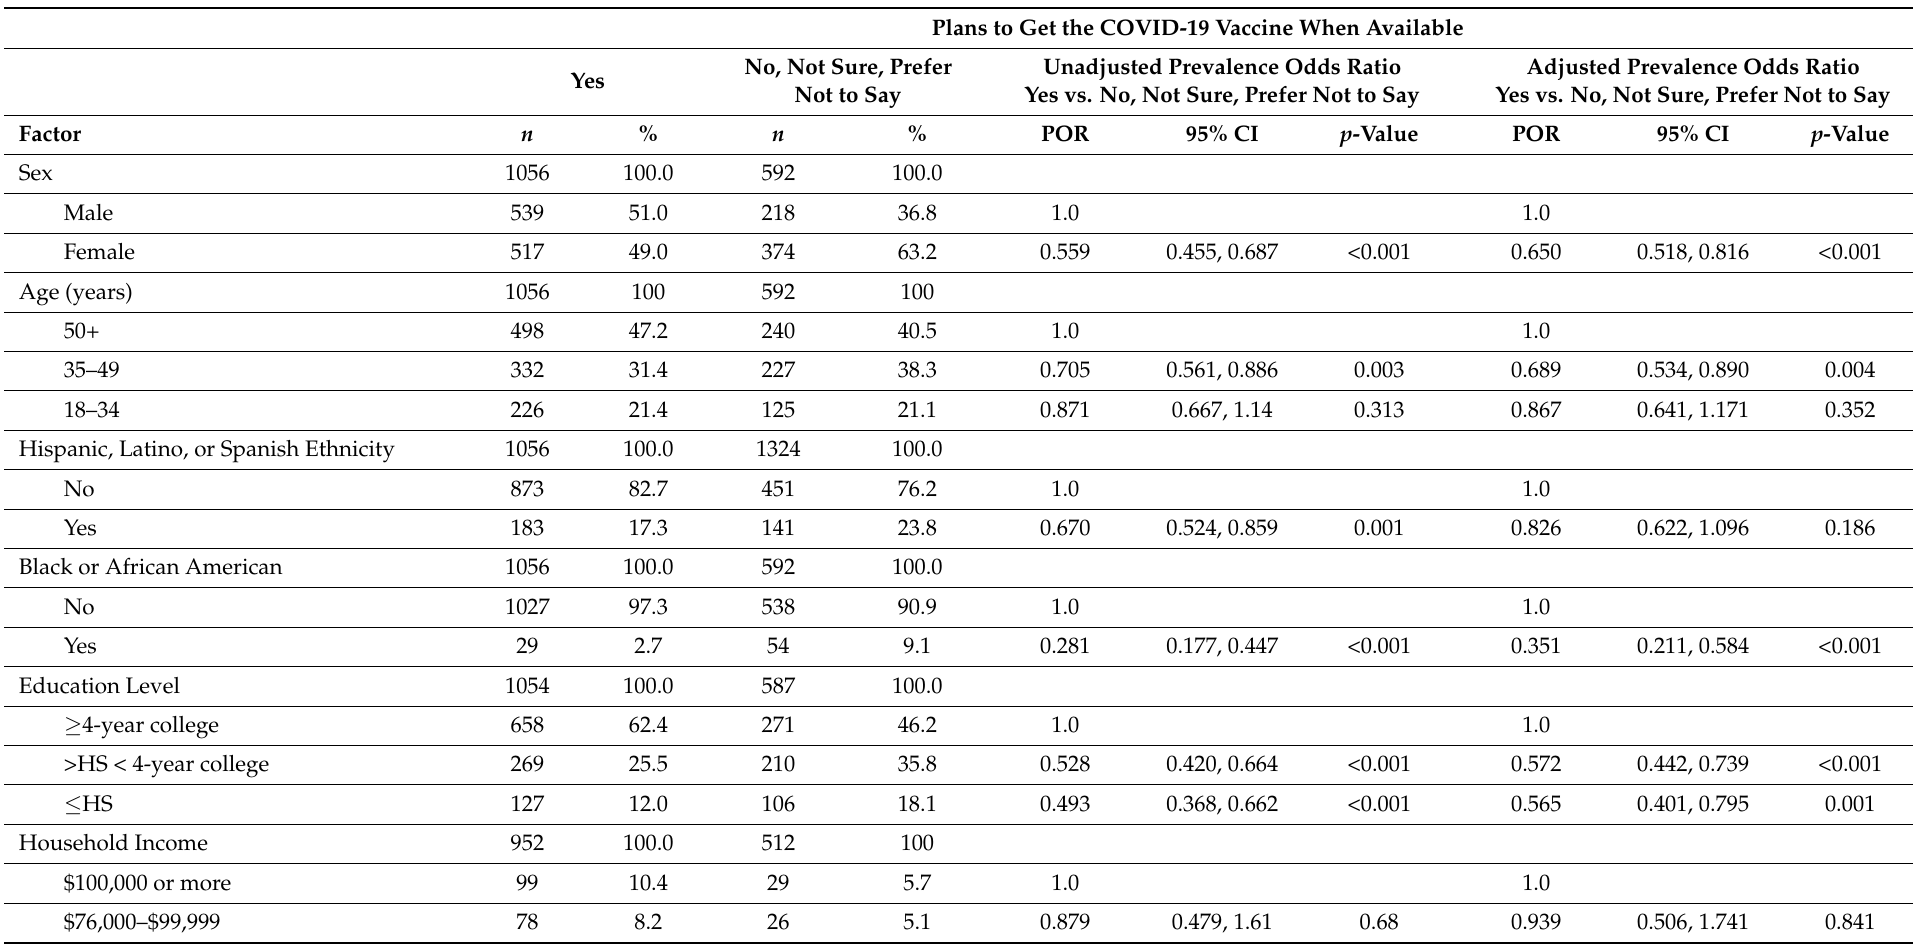
Table 3. Unadjusted and adjusted prevalence odds ratios for “Plan to get the COVID-19 vaccine when it is available” among study respondents. Plans to Get the COVID-19 Vaccine When